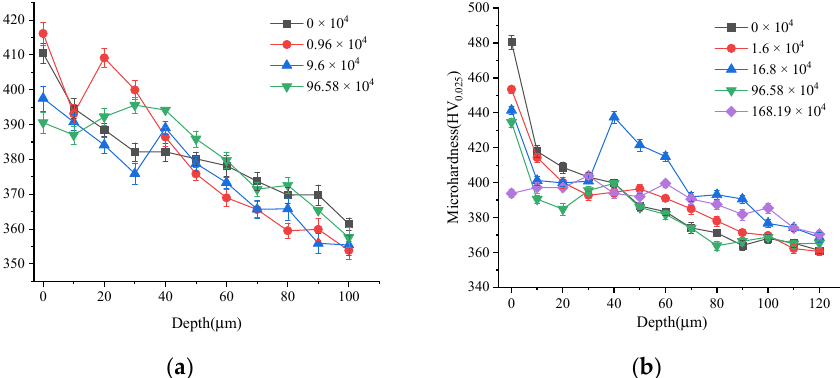
Figure 10. Variation of microhardness gradient distribution during fatigue. ( a ) Turned surface; ( b ) Ultrasonic-impacted surface.